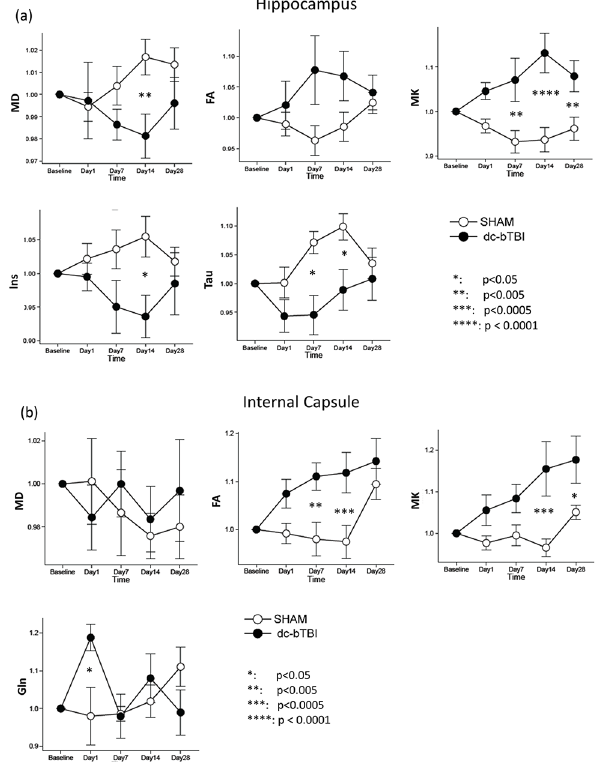
Fig 4. Changes of DKI and MRS parameters in the sham and dc-bTBI rats in the hippocampus (a) and internal capsule (b) from baseline to 28 days post injury. Temporal data in each rat were normalized to its baseline (pre-injury) value. Error bar shows standard error. Comparisons were made between sham and dc- bTBI